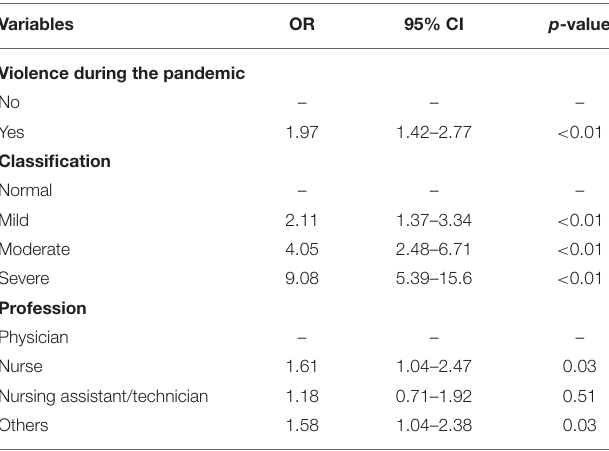
TABLE 4 | Multivariate analysis of variables related to medication initiation during the pandemic.